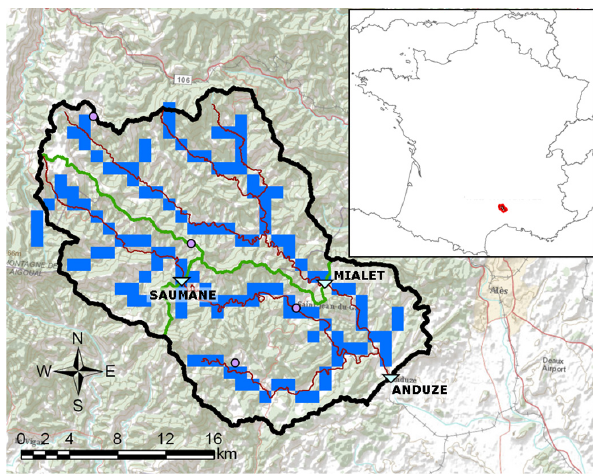
Fig. 1. Map of the Gardon d’Anduze and 1-km river network for the simulated model (in blue). Rain gauges (circles and triangles) and stream gauges (triangles) are also